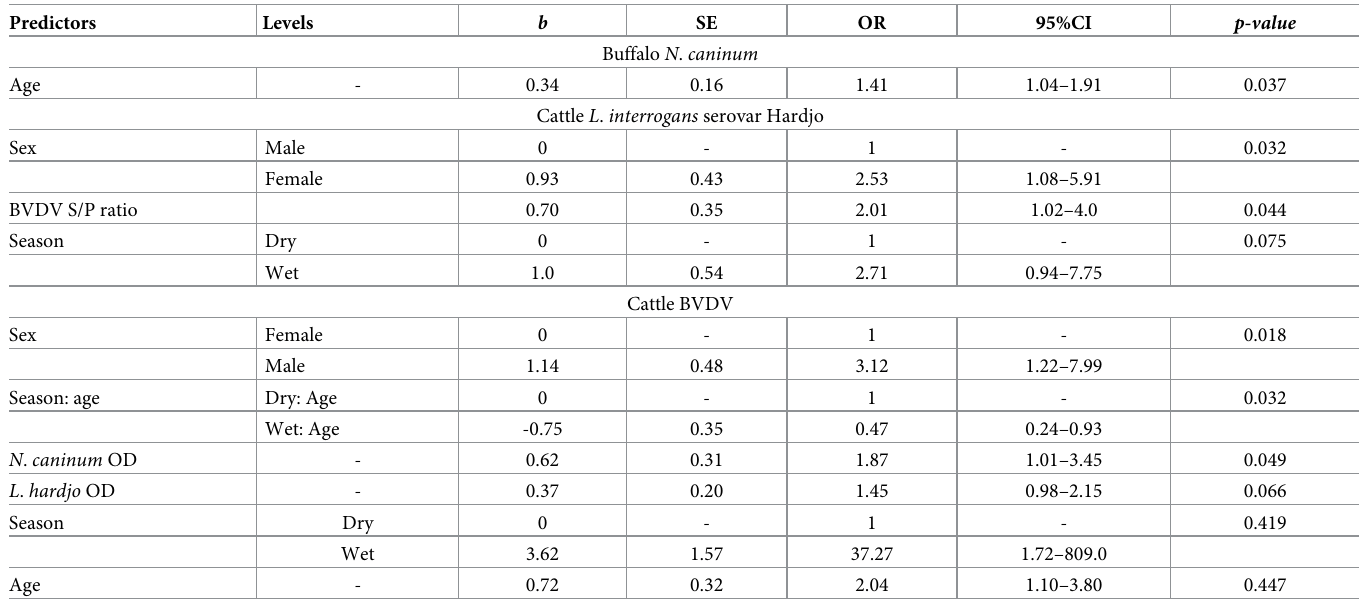
Table 8. Animal-level risk factors associated with buffalo Neospora caninum , cattle Leptospira interrogans serovar Hardjo ( L . hardjo ) and bovine viral diarrhoea virus (BVDV) seroprevalence in Lao PDR from multivariable logistic generalised linear mixed models. Predictors